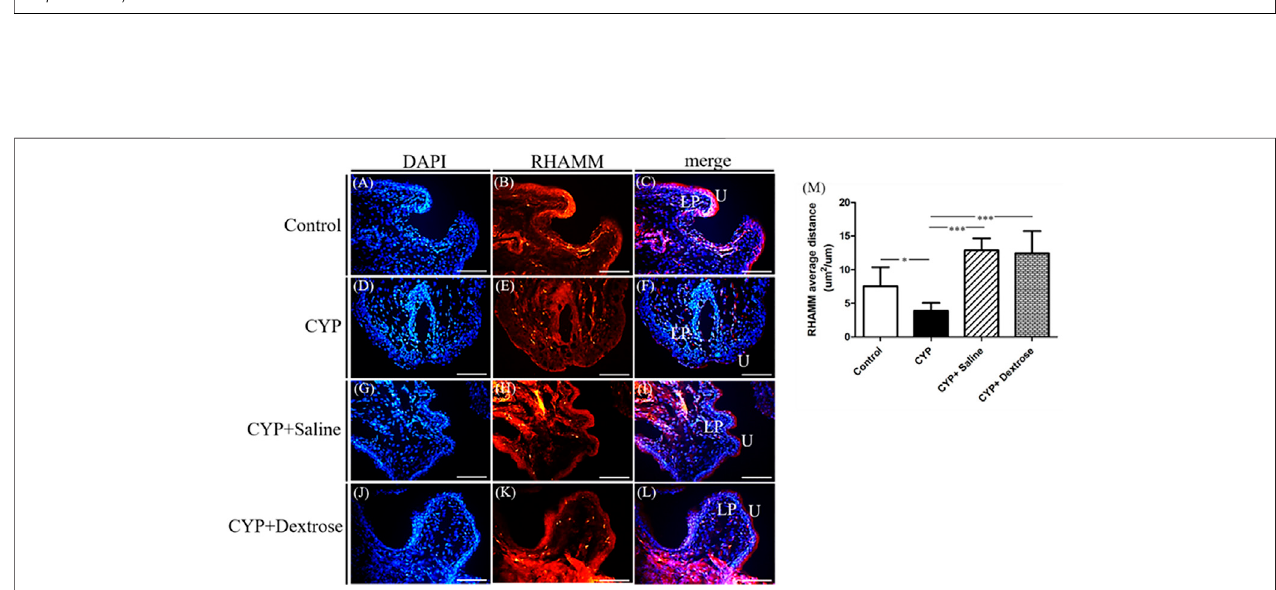
FIGURE 5 | Immuno fl uorescence staining and quantitative analysis of receptor for hyaluronic acid-mediated motility (RHAMM) of bladder tissues in interstitial cystitis rat model. (A) Control, DAPI; (B) control, RHAMM; (C) control, merge DAPI + RHAMM; (D) CYP, DAPI; (E) CYP, RHAMM; (F) CYP, merge DAPI + RHAMM; (G) CYP + saline, DAPI; (H) CYP + saline, RHAMM; (I) CYP+saline, merge DAPI + RHAMM; (J) CYP + dextrose, DAPI; (K) CYP + dextrose, RHAMM; (L) CYP + dextrose, merge DAPI + RHAMM; (M) quantitative analysis of RHAMM. (CYP (cid:1) cyclophosphamide; DAPI (cid:1) 4 ′ ,6-diamidino-2-phenylindole; U (cid:1) urothelium; LP (cid:1) lamina propria; scale bar (cid:1) 50 μ m; * p ≤ 0.05; ** p ≤ 0.01; *** p ≤ 0.001).